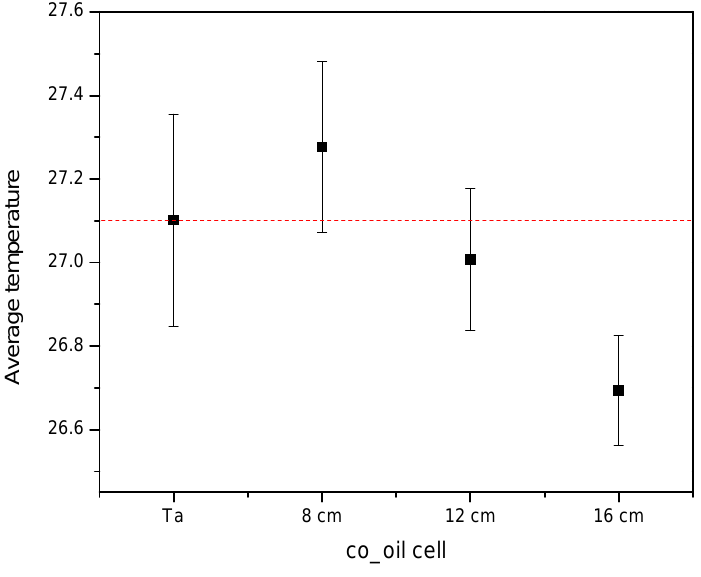
Figure 8. The average temperature for three cycles for the different co_oil cell sizes. This figure also shows average air temperature for comparison.